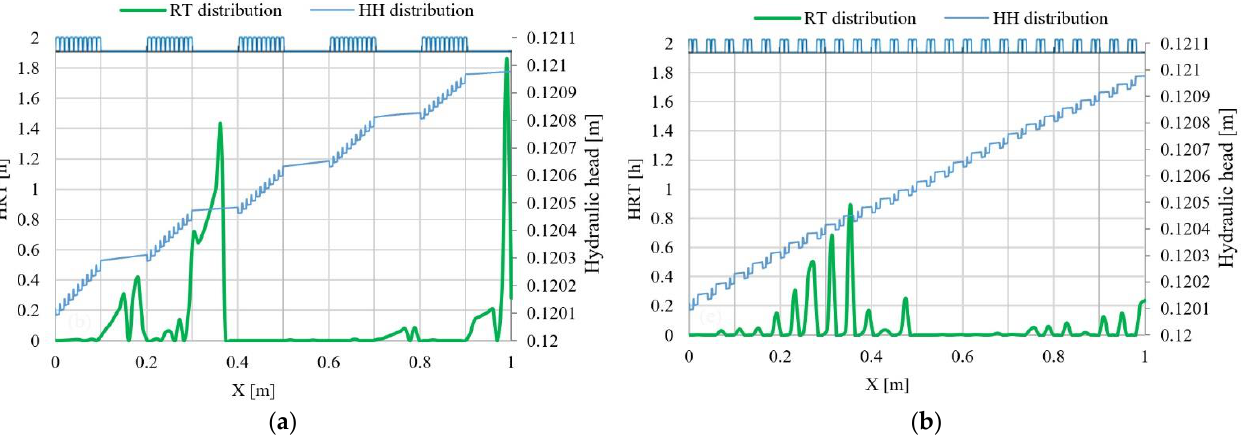
Figure 17. Variation in HRT is shown with the change of distribution of gravel-sand portion in streambed. Model setups zgst5 × 10-5 ( a ) and zgst5 × 10-25 ( b ) are used to compute the HRT distri- bution.